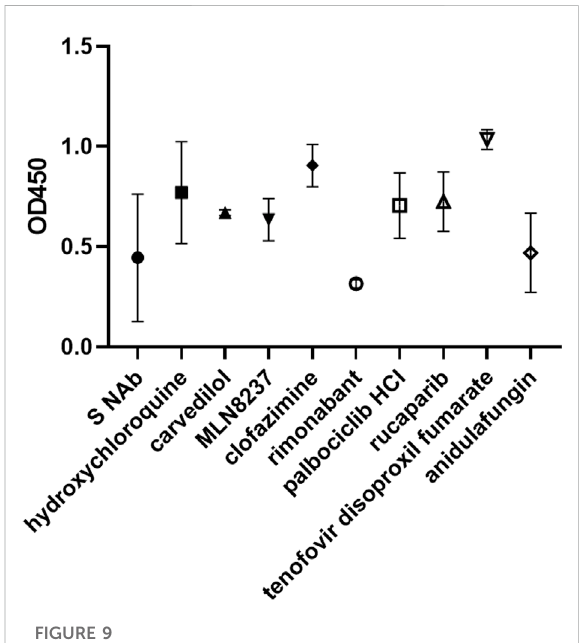
FIGURE 9 Rimonabant and anidulafungin inhibit ACE2-spike binding. Enzyme-linked immunosorbent assay of spike neutralizing antibody (S NAb) and drug inhibition of ACE2-spike binding. Data are presented as % binding of their respective solvent control and represent mean +/ − SD of 2